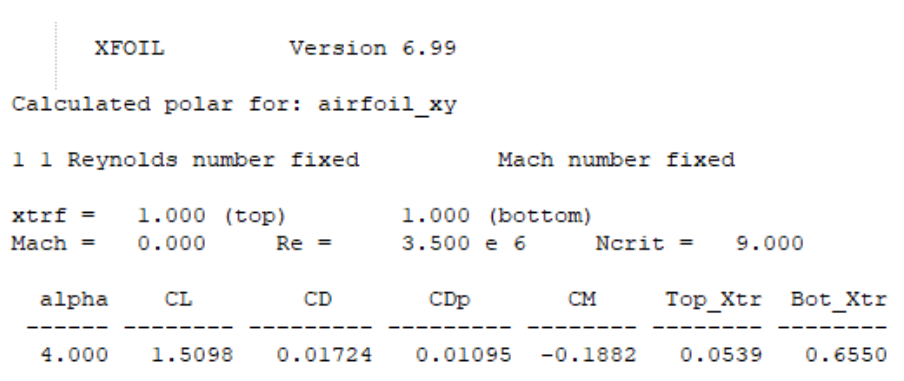
Figure 32. Morphed NACA 23012 segment-wise contribution of skin friction forces along V inf and ⟂ V inf directions.